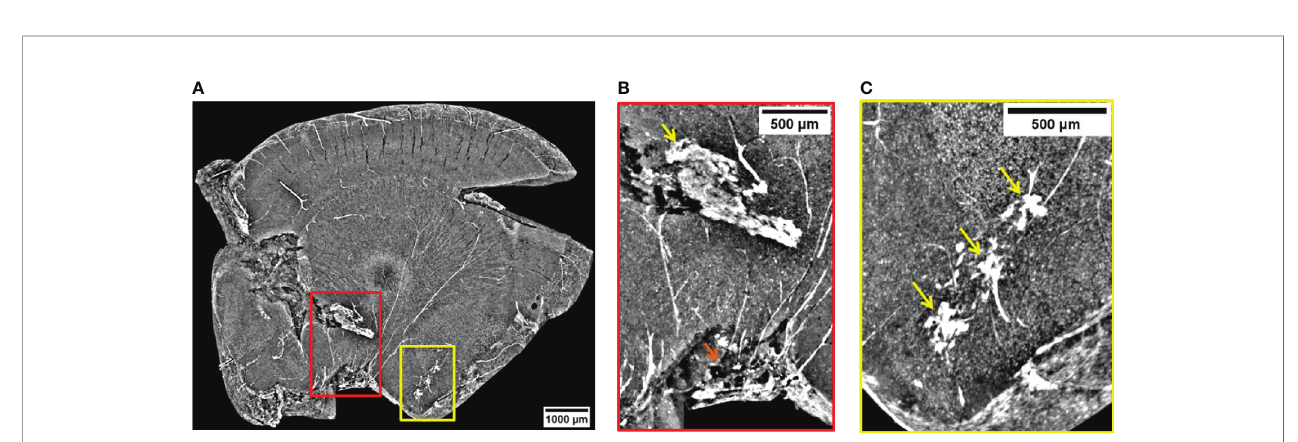
FIGURE 5 | Volume reconstruction of brain bearing metastases. (A) 732 µm thick reconstruction of a part of the brain bearing three metastases targeted by NPs. (B) Visualization of a metastasis invading the thalamus (yellow arrow) and one developed close to the pituitary gland (orange arrow). (C) View on some three metastases in early